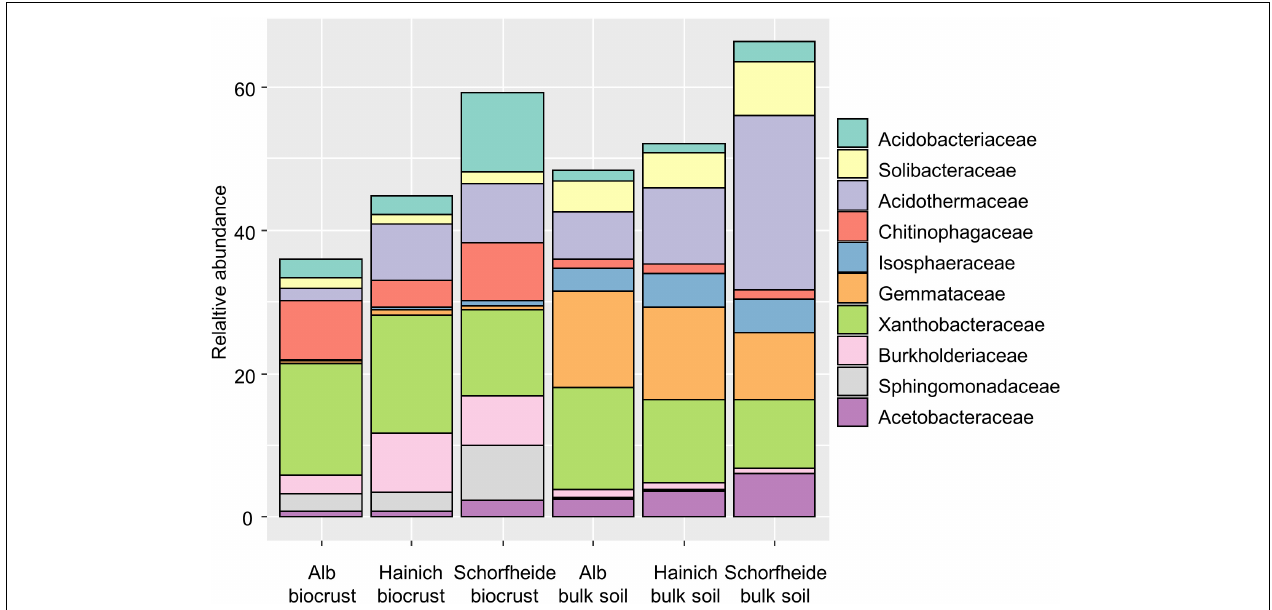
FIGURE 3 | Taxonomic composition of bacteria on the family level in biocrusts and bulk soil from three sampling sites. Families with the highest relative abundance ( > 5%) are shown; n = 9 for each sampling site and soil type. Taxonomic composition on the phylum level is given in Supplementary Table 2 .